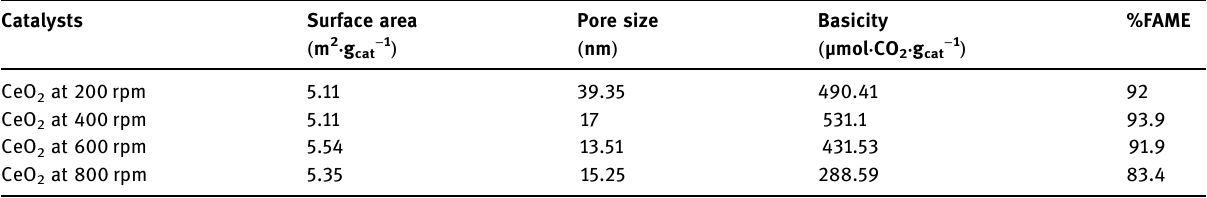
Table 2: Properties of CeO 2 using di ff erent stirring rates at 3% oxalic concentration